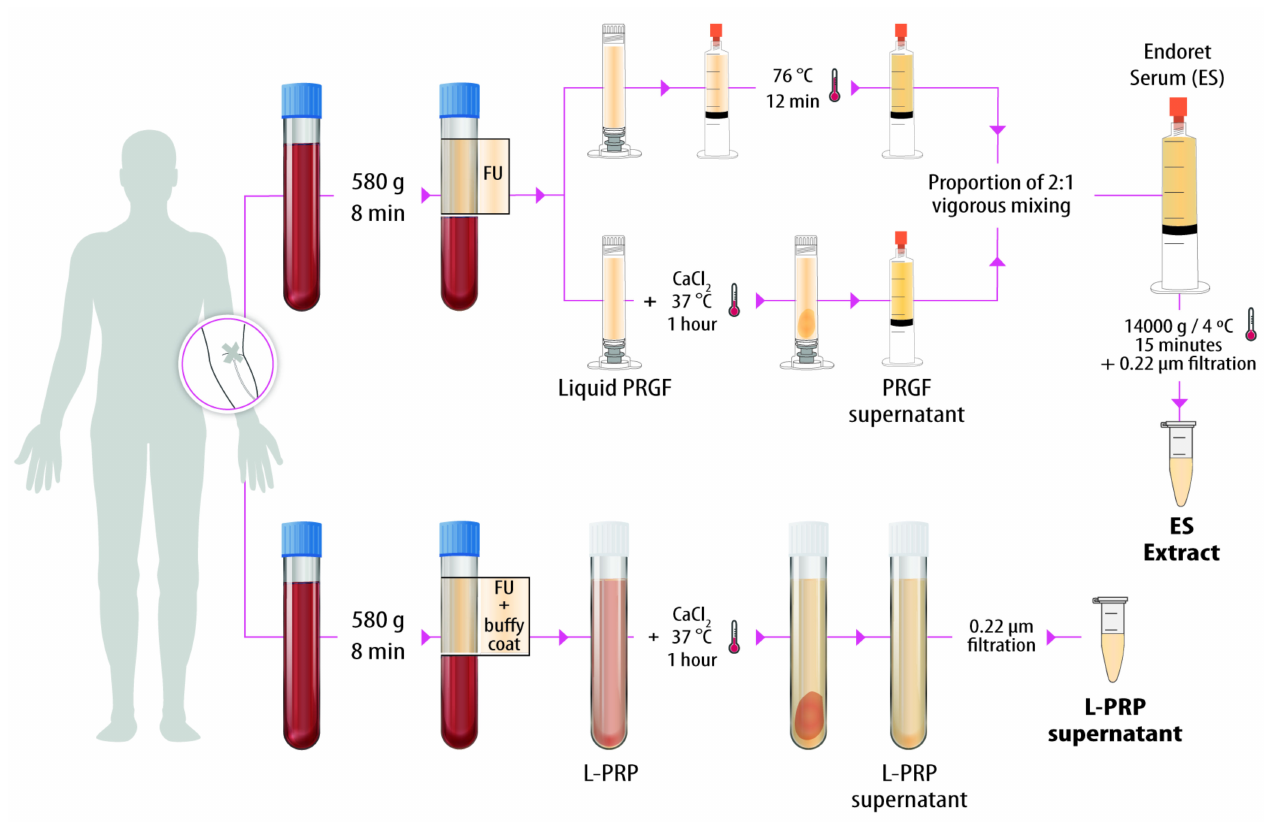
Figure 1. Schematic illustration of the process of obtaining the two blood derivatives. Blood was drawn from three donors in order to prepare the two blood derivatives, Endoret serum (ES) and leukocyte- and platelet-rich plasma (L-PRP). To obtain ES, the whole plasma (FU) column (excluding the buffy coat) was fractionated; a part of this PRGF was activated with 10% CaCl 2 in order to obtain PRGF supernatant. The remaining non-activated liquid PRGF was subjected to heat treatment to jellify proteins. Finally, both components were mixed. In the case of L-PRP, the whole plasma column plus the buffy coat layer was collected and activated with 10% CaCl 2 . ES liquid extracts and L-PRP supernatants were filtered, aliquoted and stored at − 80 ◦ C until use. No sample pooling was